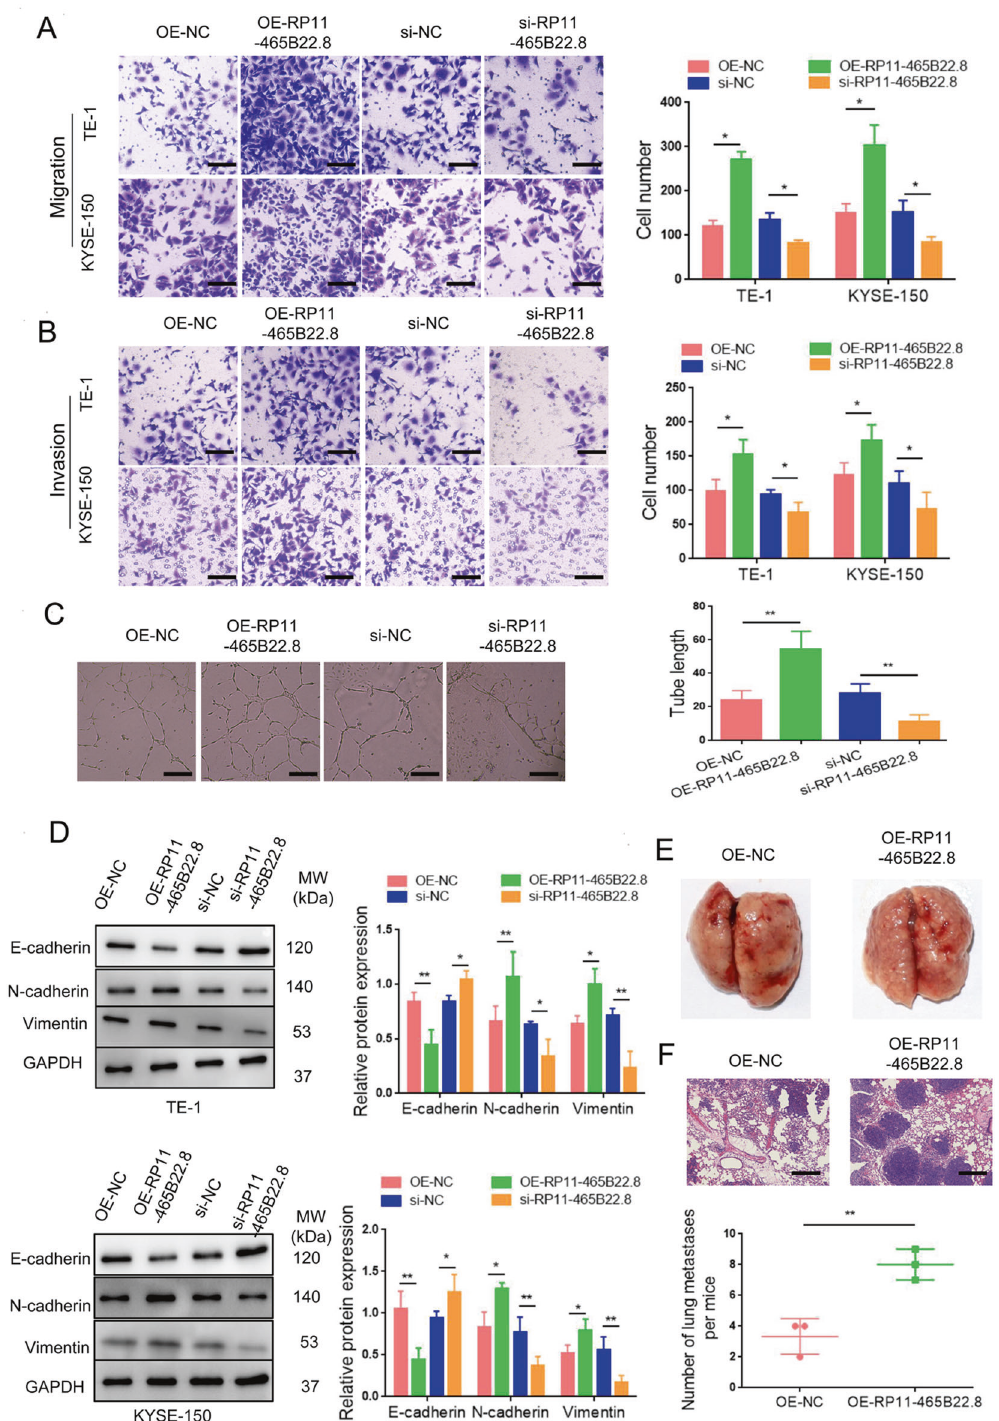
Fig. 3 LncRNA RP11-465B22.8 promotes EC cell migration, invasion, and metastasis. A , B The migration and invasion in EC cells transfected with lncRNA RP11-465B22.8-overexpressing plasmid or si-RP11-465B22.8. C Tube formation of HUVECs treated with media from EC cells transfected with lncRNA RP11-465B22.8-overexpressing plasmid or si-RP11-465B22.8. D The expression levels of epithelial (E-cadherin) and mesenchymal markers (N-cadherin and vimentin) in EC cells transfected with lncRNA RP11-465B22.8-overexpressing plasmid or si-RP11- 465B22.8. E Representative images of lung tissues from mice injected with lncRNA RP11-465B22.8-overexpressed cells or control cells ( n = 3). F H&E staining of lung sections from mice injected with lncRNA RP11-465B22.8-overexpressed cells or control cells ( n = 3). * P < 0.05, ** P < 0.01.